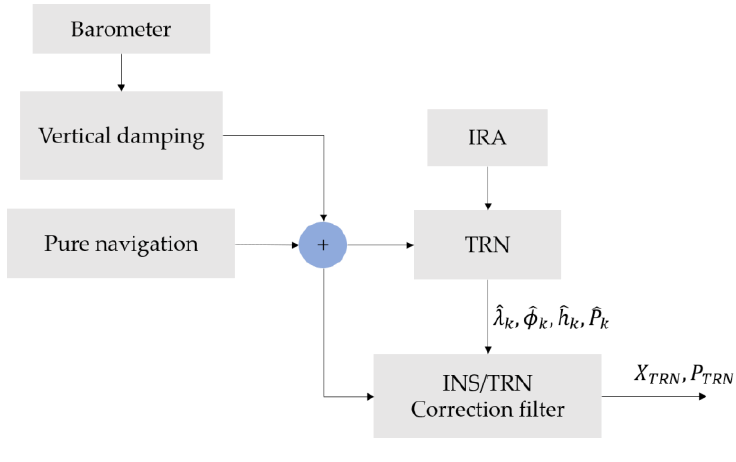
Figure 1. TRN configuration.